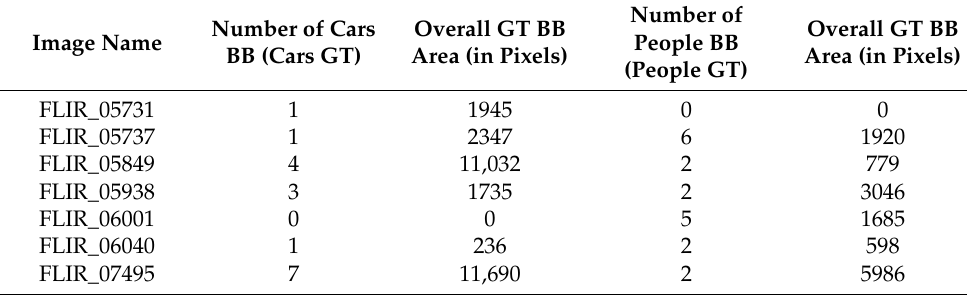
Table A2. Nightlight images, Test